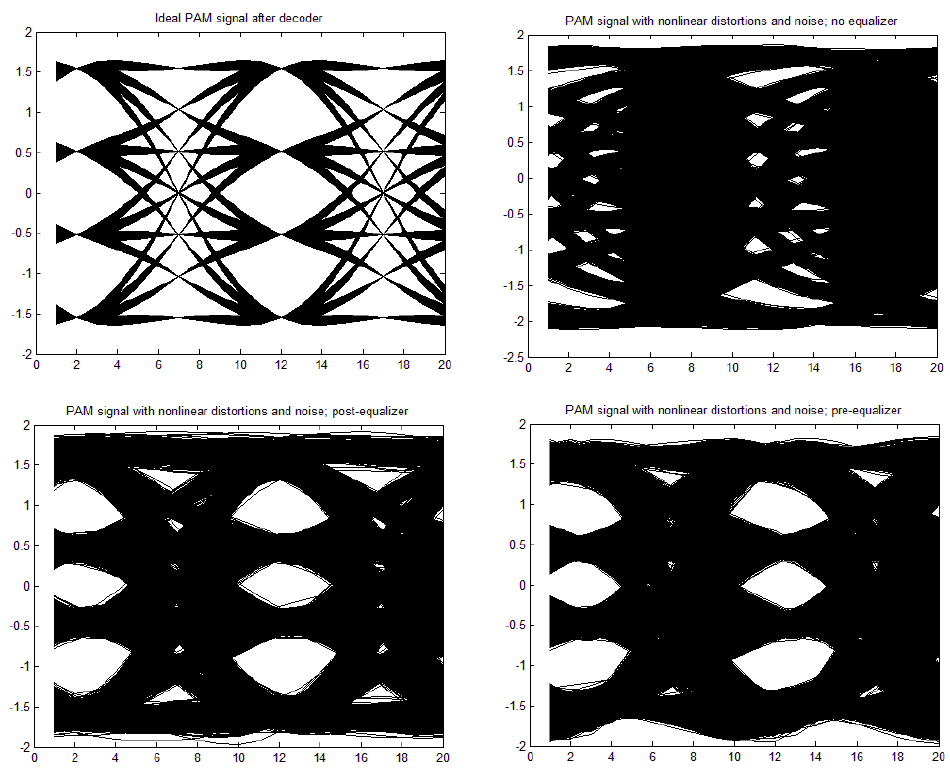
Figure 6. Eye patterns for PAM-4. Moderate nonlinearity: [1, − 0.1, 0.05, 0.02], and α = 1, SNR = 20 dB, and τ = 0.3T.